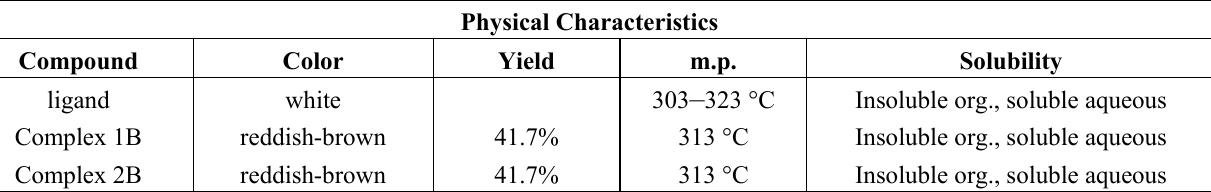
Table 1. Physical and elemental analysis data